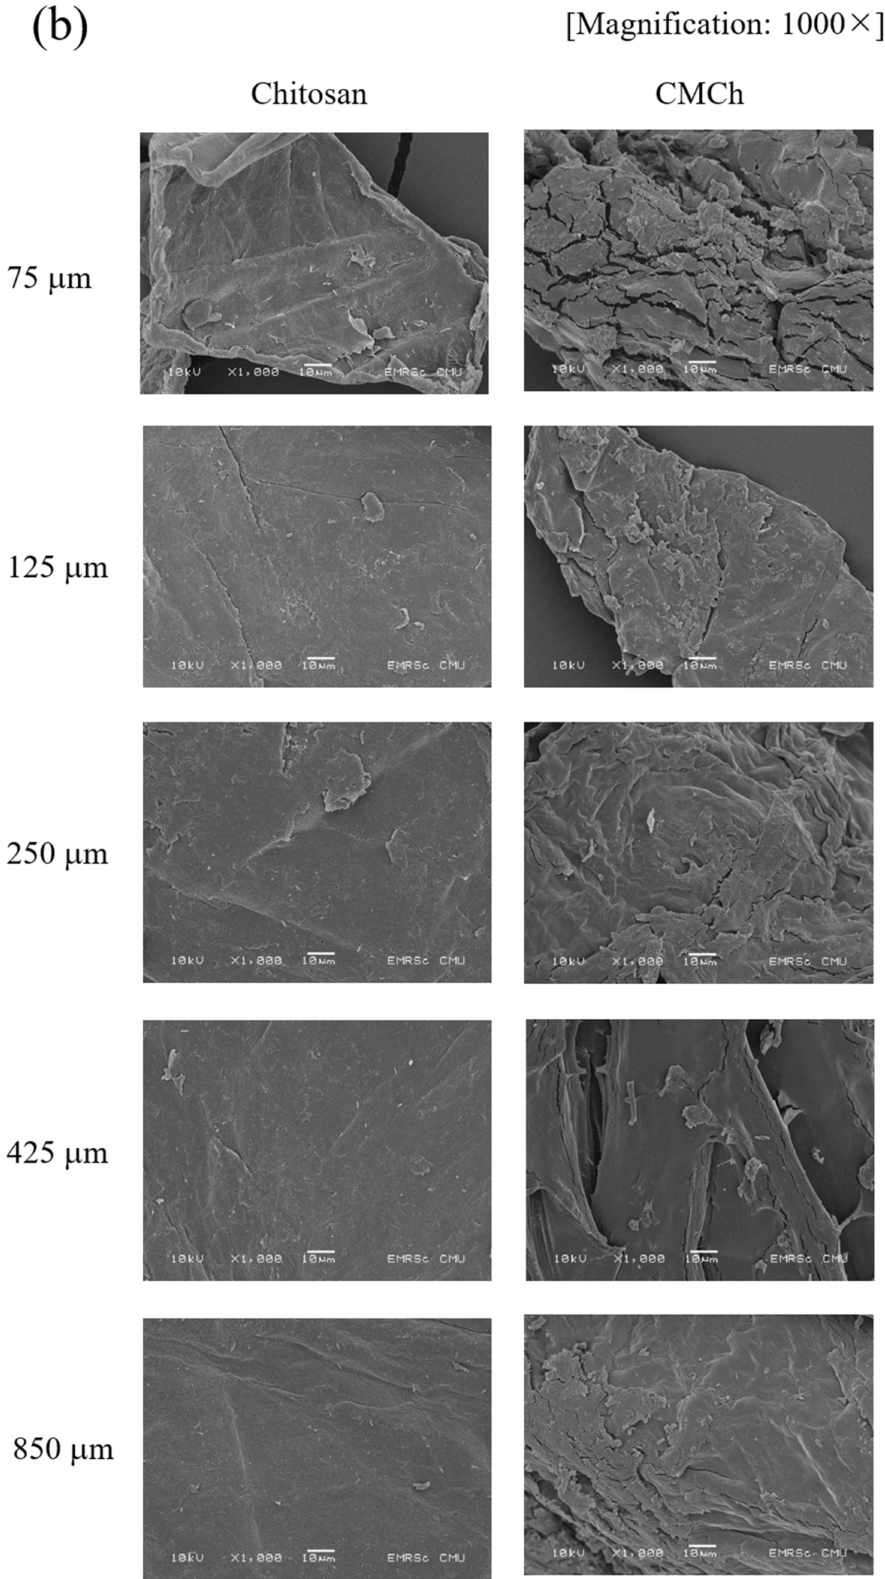
Figure 3. SEM images of chitosan and CMCh powders prepared from chitosan of different particle sizes: ( a ) 70 × and ( b ) 1000 ×